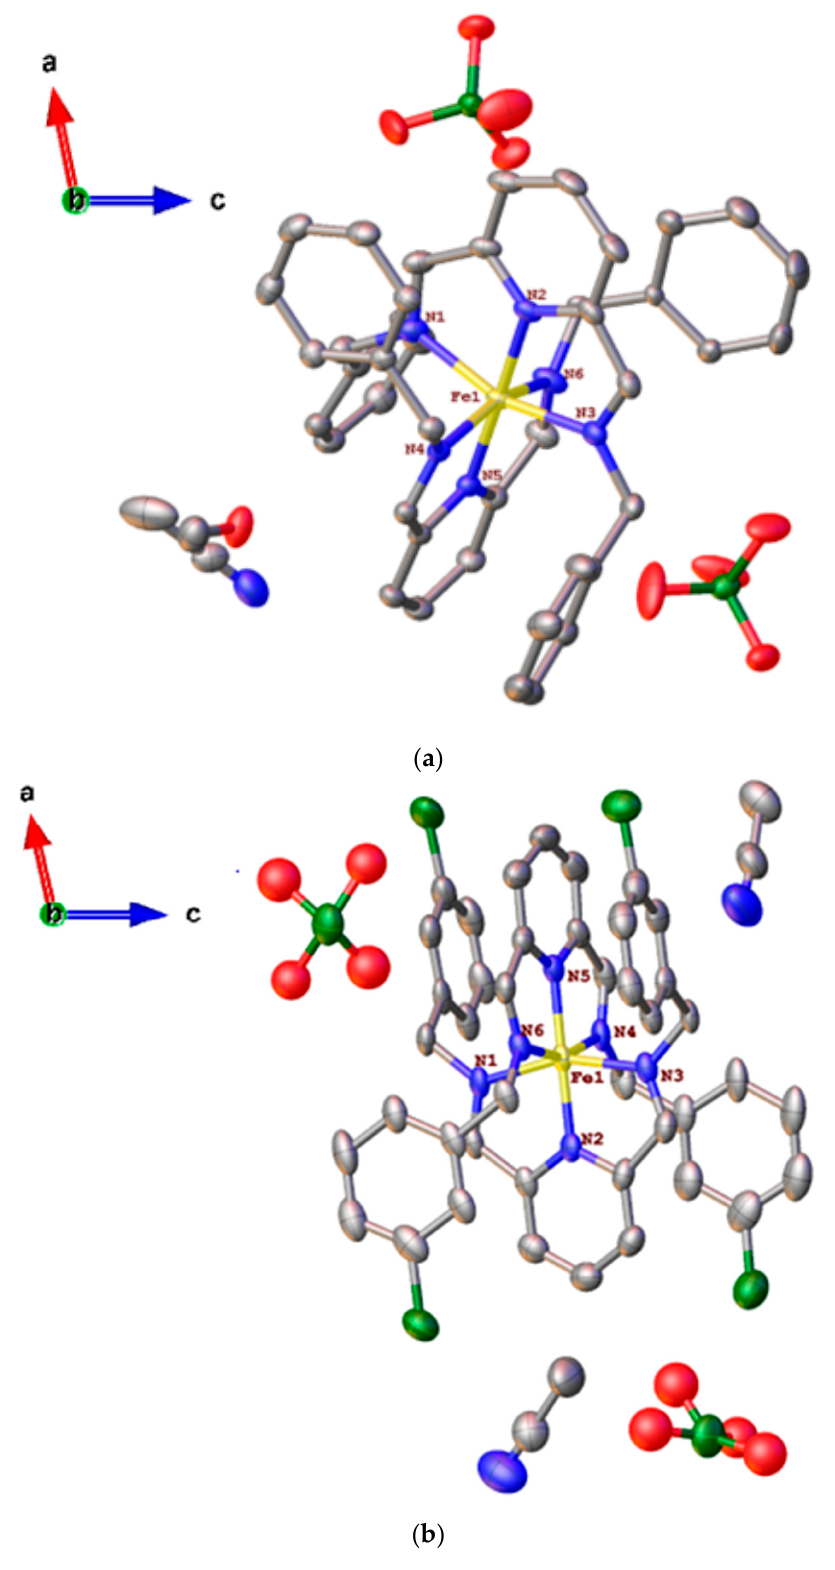
Figure 2. Labelled ORTEP drawing of 1 ( a ) and 2 ( b ) both in b-axis. Thermal ellipsoids are drawn on 30% probability level. Hydrogen atoms have been omitted for clarity. Color code: Yellow-green, Fe; blue, N; grey, C; green, Cl and red, O.